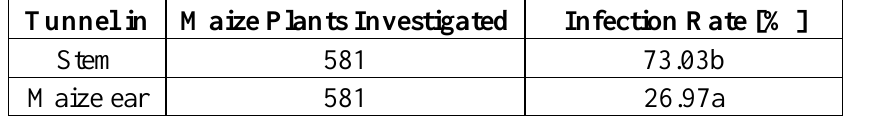
Table 3. Position of Ostrinia nubilalis tunnels in same maize plants (Zamora).